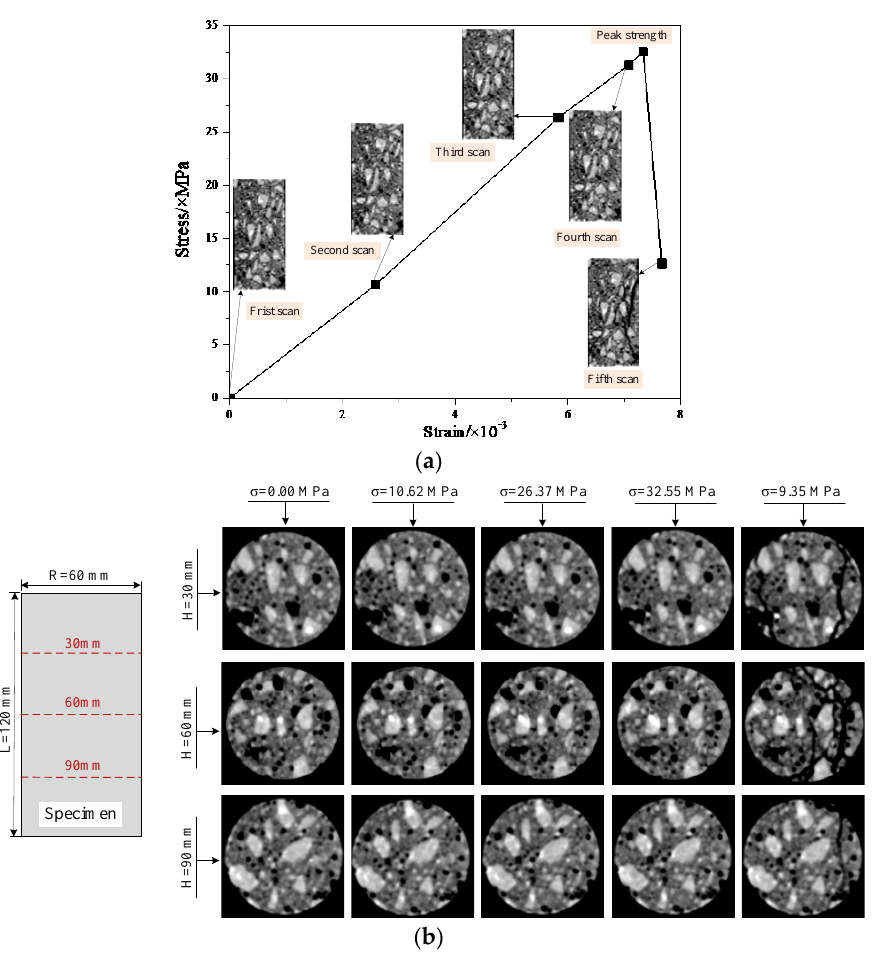
Figure 2. Experimental results of the concrete CT test, ( a ) Stress-strain curves of CONC-61 specimen, ( b ) Cross-sectional CT images of concrete specimens in different height at different stress